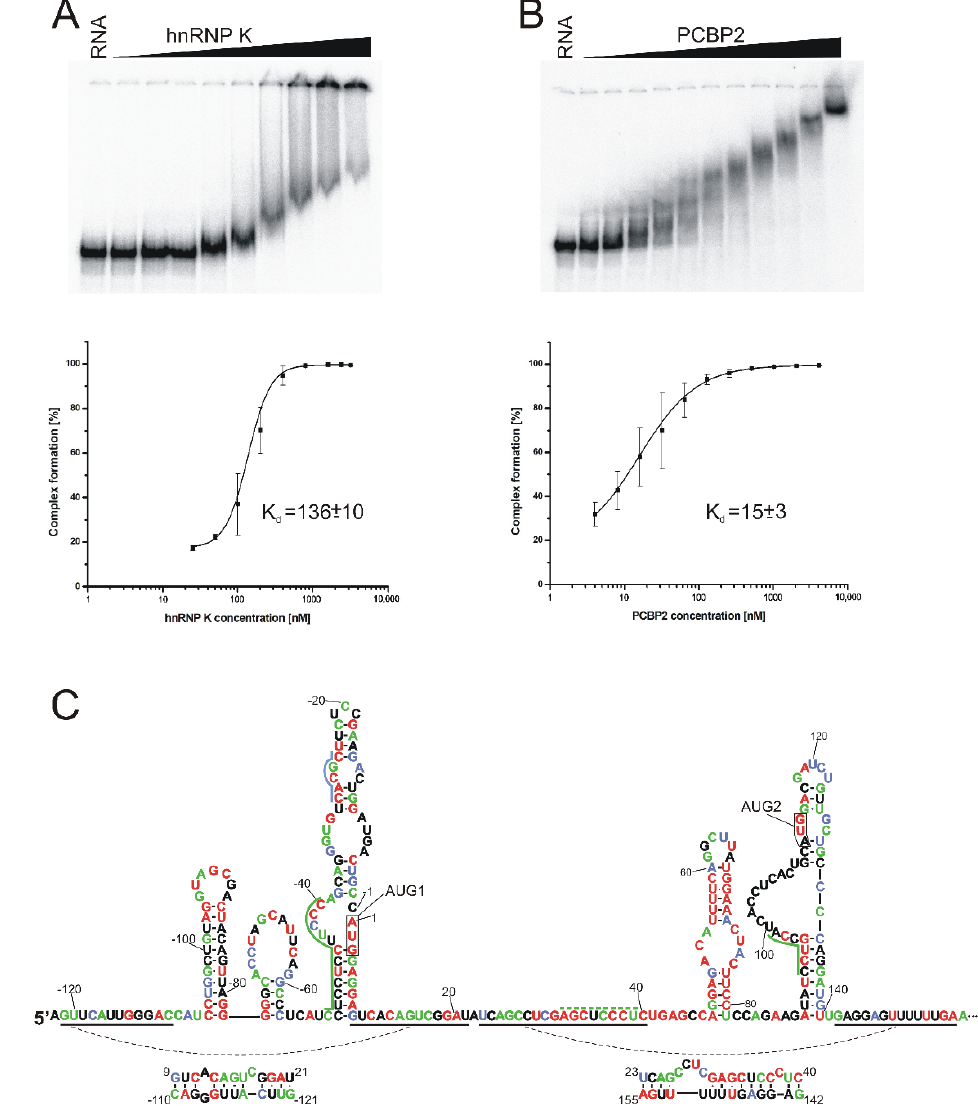
Figure 7. hnRNP K and PCBP2 proteins bind to the 5′ -terminal region of p53 mRNA. EMSA assays and graphs representing dissociation constant (K d ) curves for hnRNP K ( A ) and PCBP2 ( B ). EMSA experiments were conducted by incubation of [ 32 P]-labeled RNA-122/201 with increasing concentra- tion of hnRNP K or PCBP2. EMSA products were resolved on 4% polyacrylamide native gels. In the first line of each EMSA panel, RNA was incubated with no protein added. For the calculation of dissociation constants, at least three independent experiments were conducted. ( C ) Secondary struc- ture model of the 5′ -terminal region of mouse p53 mRNA with the level of each nucleotide conser- vation marked based on the alignment of p53 mRNA sequences from eleven different species (mod- ified from [32]) with the proposed binding sites of hnRNP K (blue) and PCBP2 (green) proteins. The nucleotides are colored according to their percentages of conservation (red, 100%; green, 80–99%; blue, 60–79%).